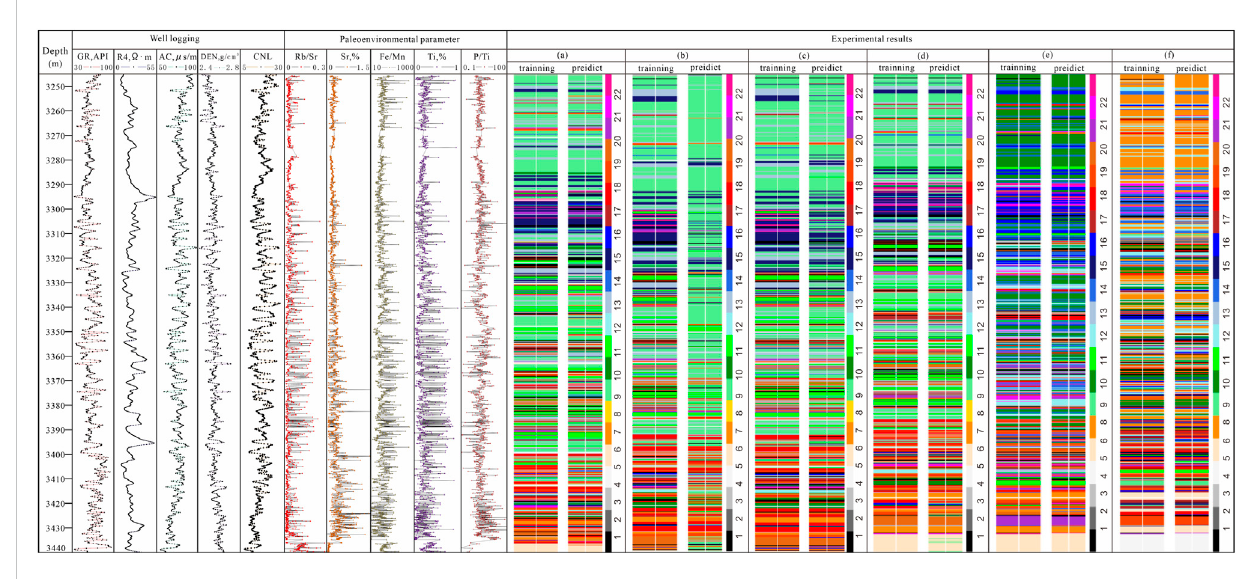
FIGURE 11 Shale lithofacies type modeling results at Well FY1 based on machine learning.